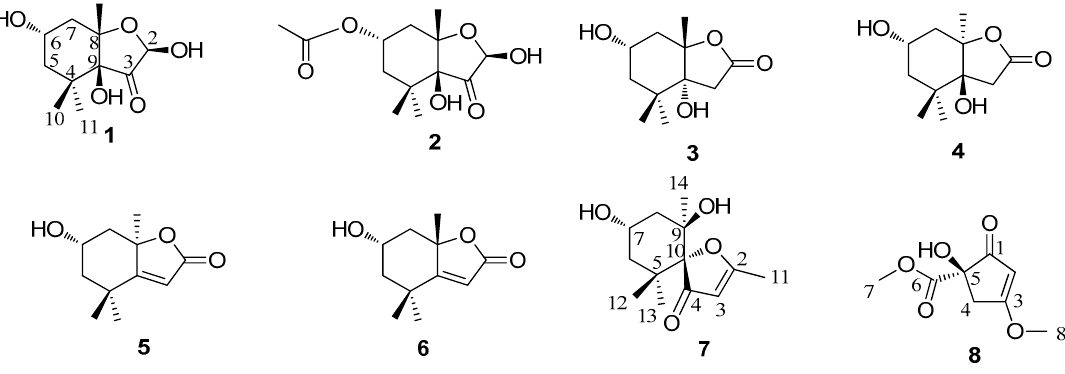
Figure 1. Chemical structures of compounds 1 – 8 isolated from S. naozhouense .